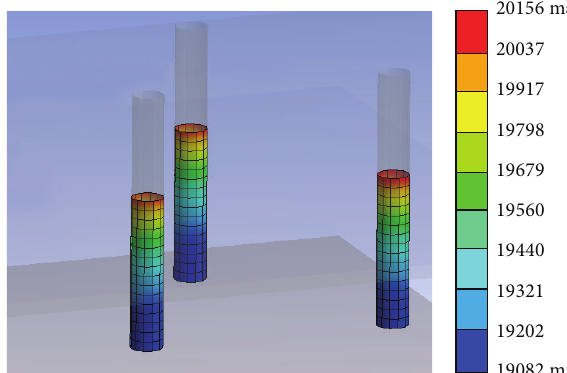
Figure 9: Pressure force due to wave loading.